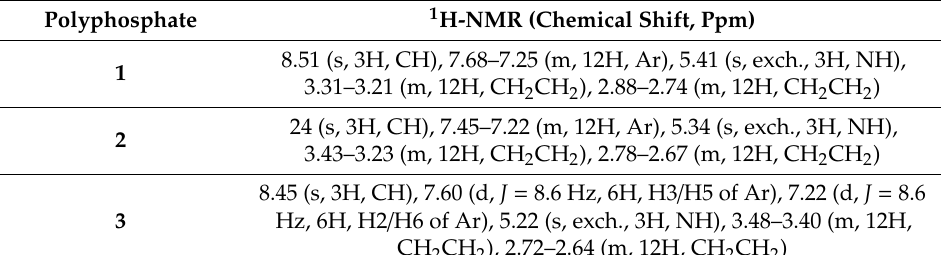
Table 3. 1 H-NMR spectral data for 1 – 3 .